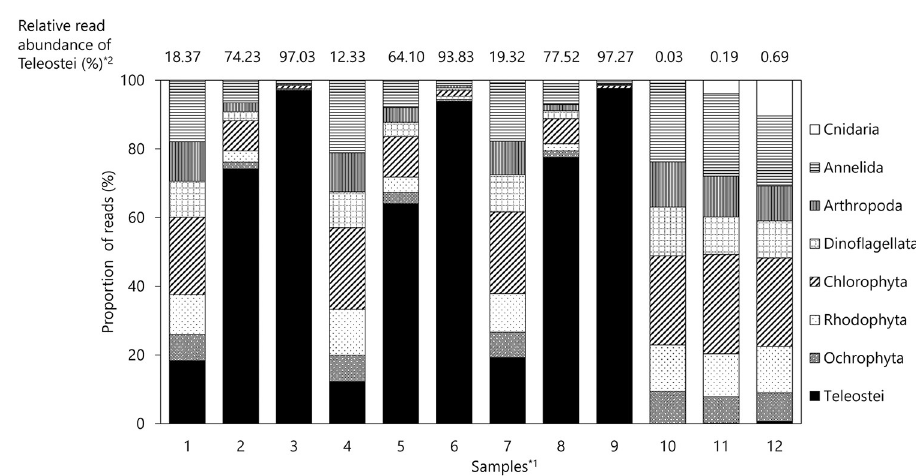
Fig 4. Proportion of read numbers of the organisms contained in the mock community samples obtained by metabarcoding analysis. � 1 : Samples shown in Table 3. � 2 : Proportion of fish reads to all reads obtained for each